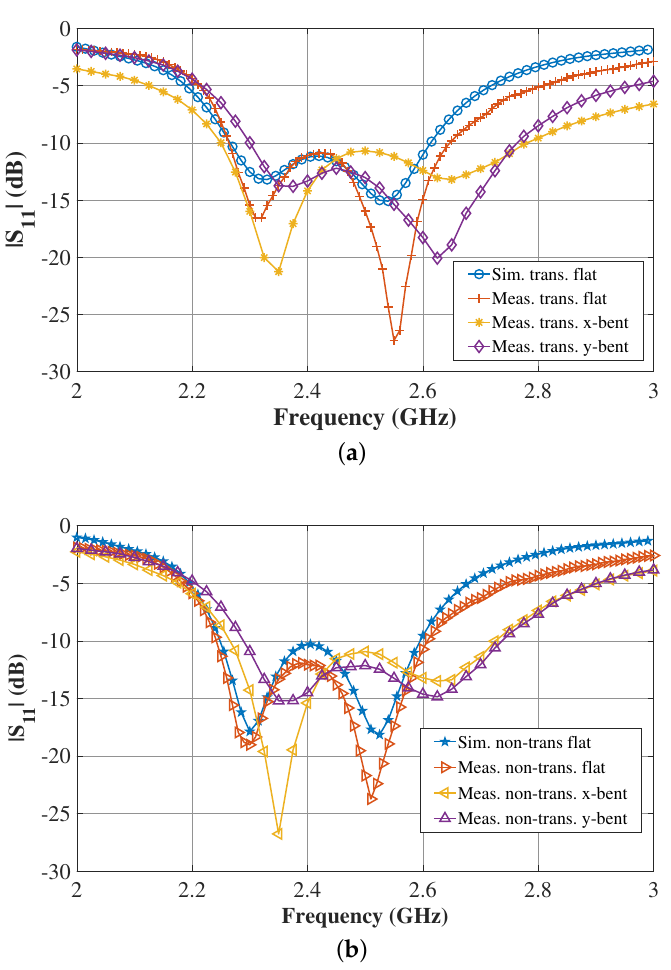
Figure 22. Simulated and measured | S 11 | vs. frequency: ( a ) transparent antenna, ( b ) non-transparent antenna.